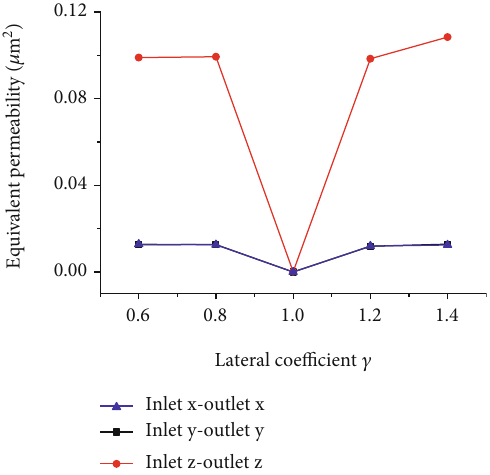
Figure 12: Curve of equivalent permeability with di ff erent lateral coe ffi cient γ